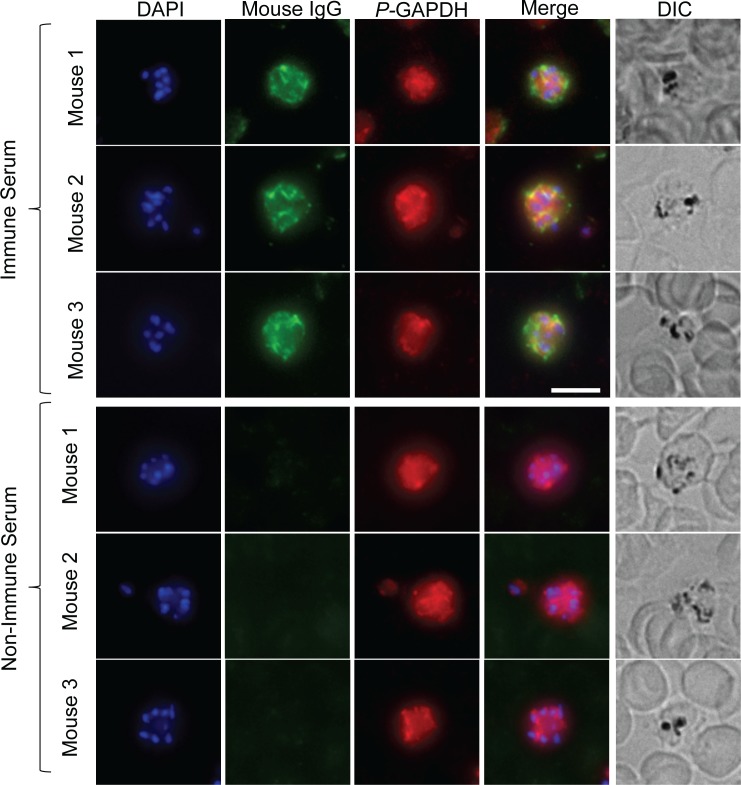
Py17XNL-specific IgG binds strongly to internal structures within schizonts of pRBC.P. yoelii 17XNL-infected blood was harvested from 3 separate rag1-/- passage mice and stained with immune (top panels) or non-immune (bottom panels) serum (green). Parasites were counterstained with anti-GAPDH (red) to delineate the parasite, and DAPI (blue) to highlight the parasite nuclei. Merge images and DIC images are also shown. Images are representative of multiple pRBC assessed for each mouse. Scale Bar = 5μm.